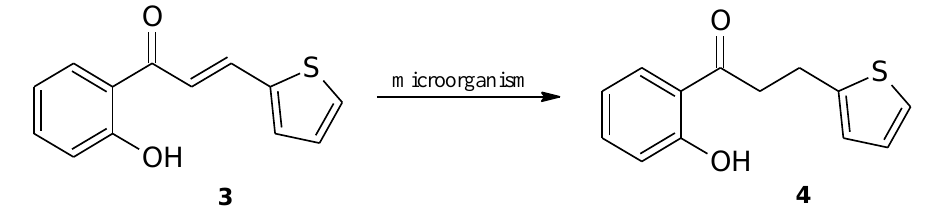
Molecules 2019 , 24 , x FOR PEER REVIEW 5 of 10